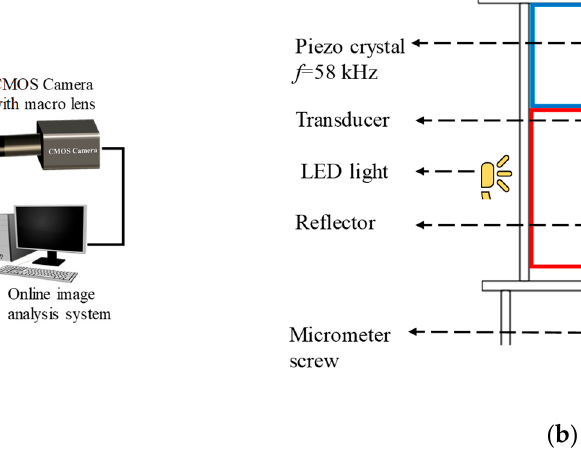
Figure 2. Sketch of the experimental setup: ( a ) the ultrasonic levitator, the video camera (CMOS MQ013xG-ON, XIMEA GmbH), and long-distance macro lens. ( b ) Backlighting LED source and the drying chamber, which consists of heating and cooling chambers.